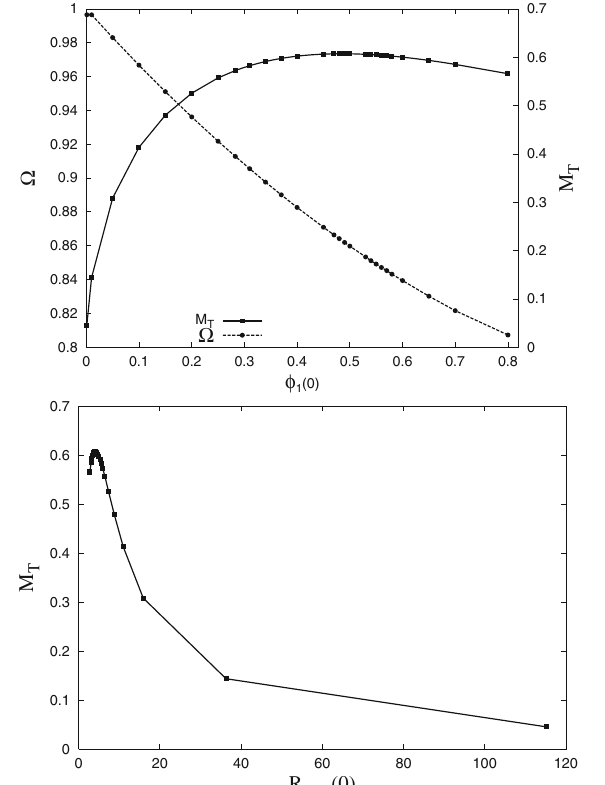
/ m ) and fundamental frequency of an oscillaton as a function of Fig. 6 Top: Total mass (in units of M 2 Planck the central value of the scalar field φ 1 ( r = 0 ) . The maximum mass is M max = 0 . 607 M 2 Planck / m . Bottom: Plot of the total mass versus the radius at which g rr achieves its maximum. Reprinted with permission from Alcubierre et al. (2003); copyright by